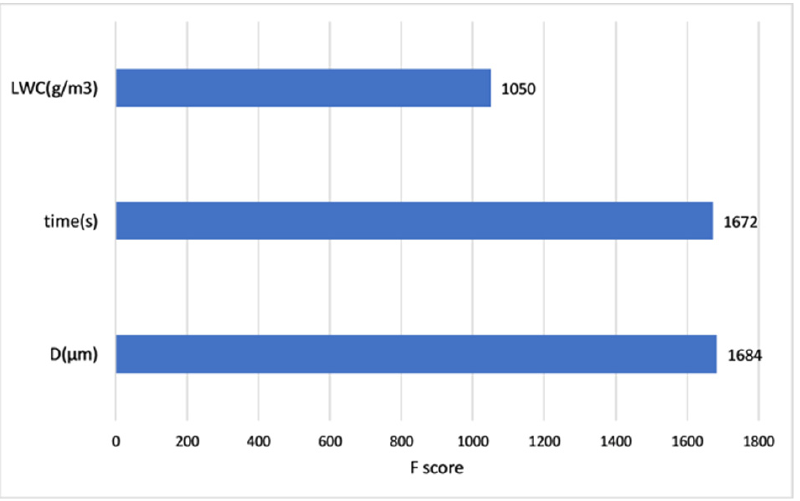
Figure 8. Bar chart of XGBoost feature importance in regard to icing severity level prediction [26].